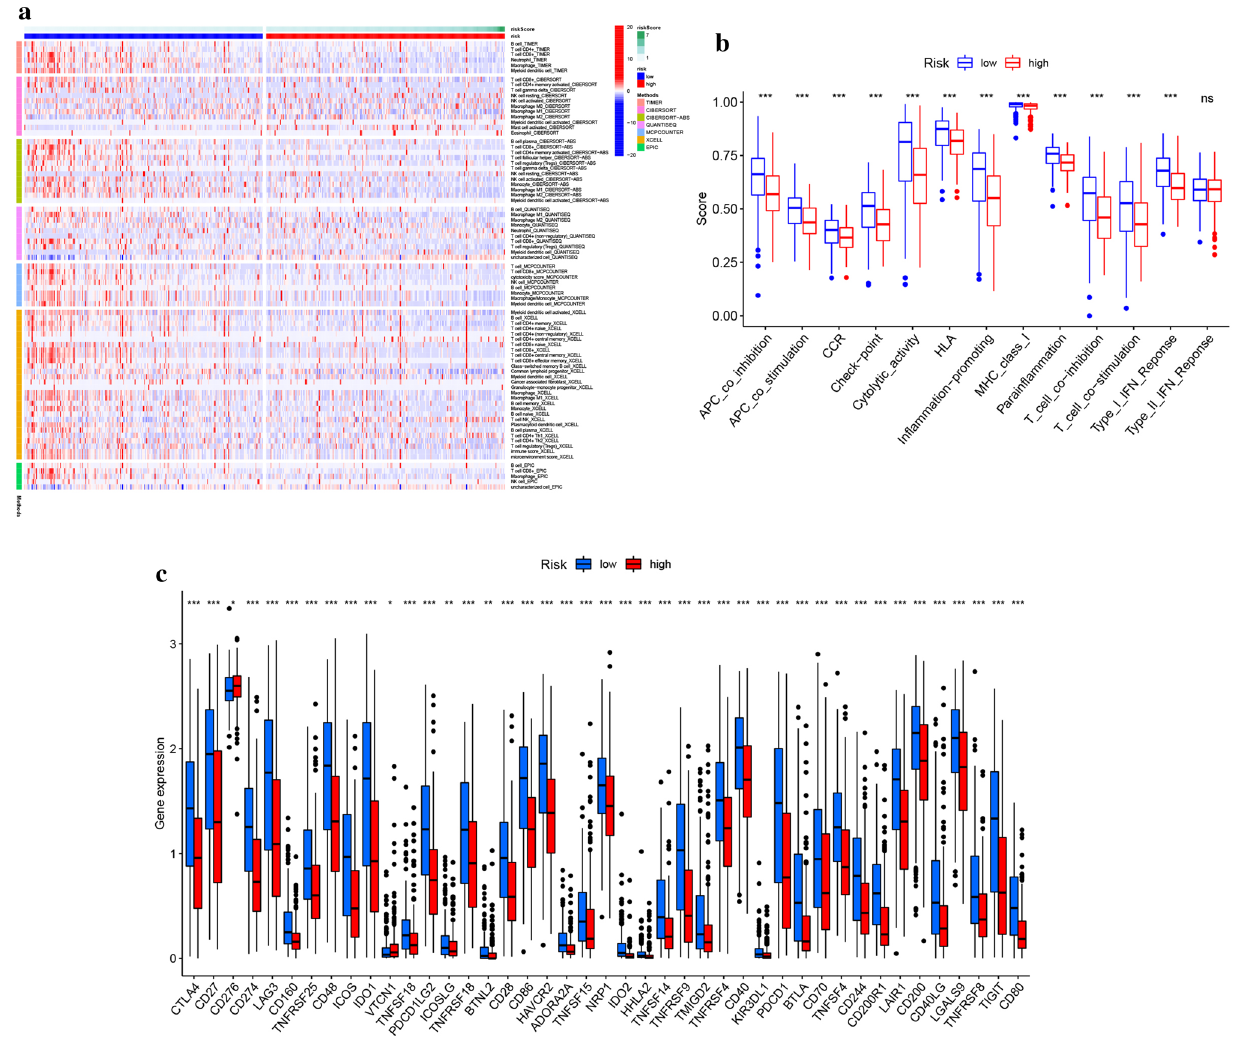
TCGA cohort. b ssGSEA for the association between immune cell subpopulations and related functions. c Expression of immune check- points among high- and low-risk groups in TCGA